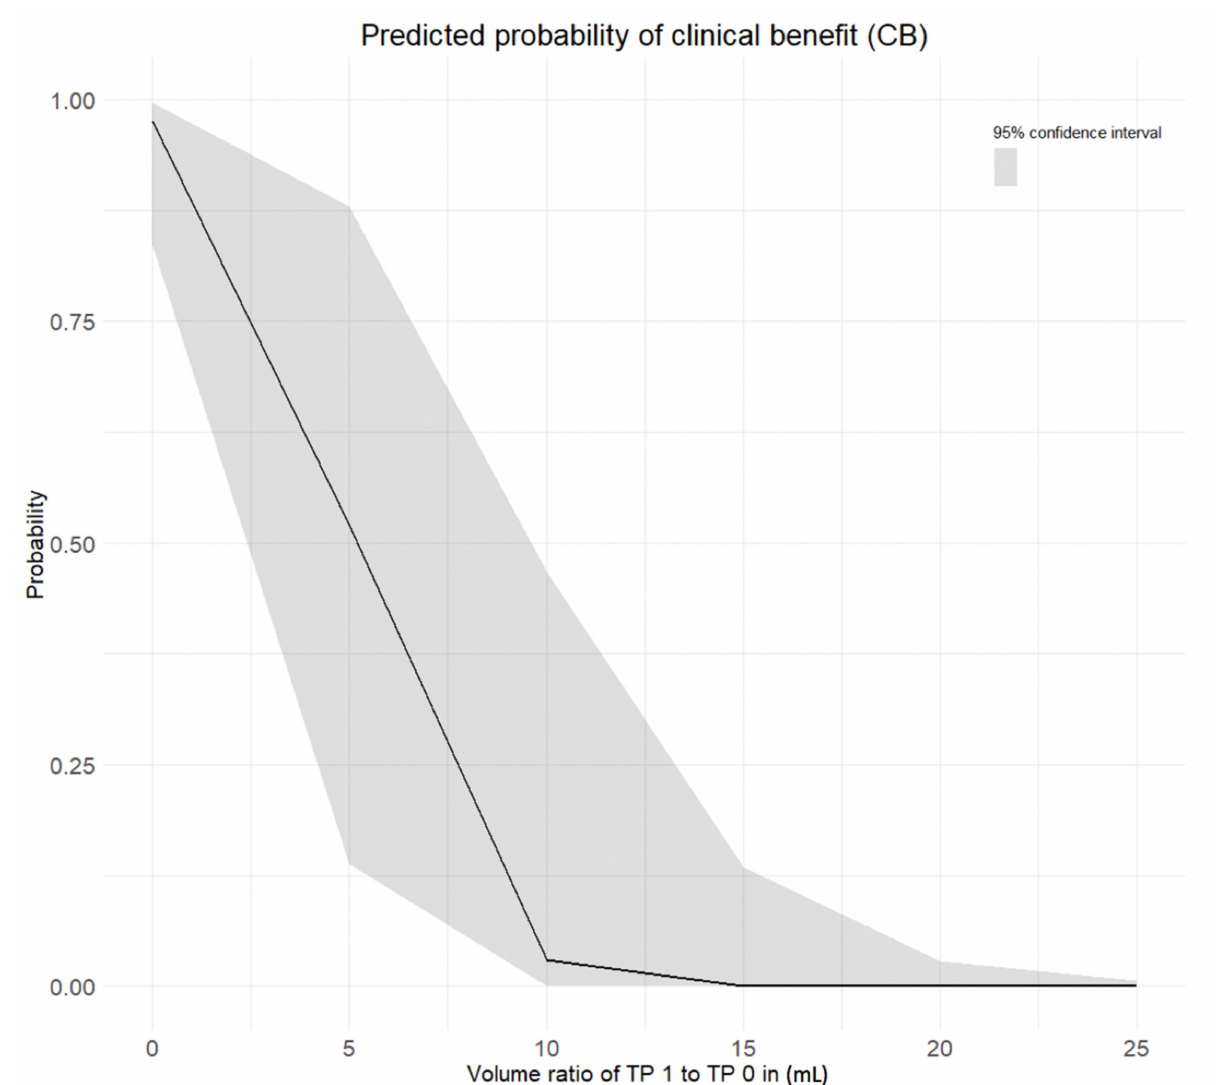
Figure 5. Predicted probability of clinical benefit at TP 2 based on volume ratio TP1 to TP 0 (in ml). On the x-axis: Volume ratio TP 1 to TP 0 (in ml). On the y-axis: Probability of clinical benefit at TP